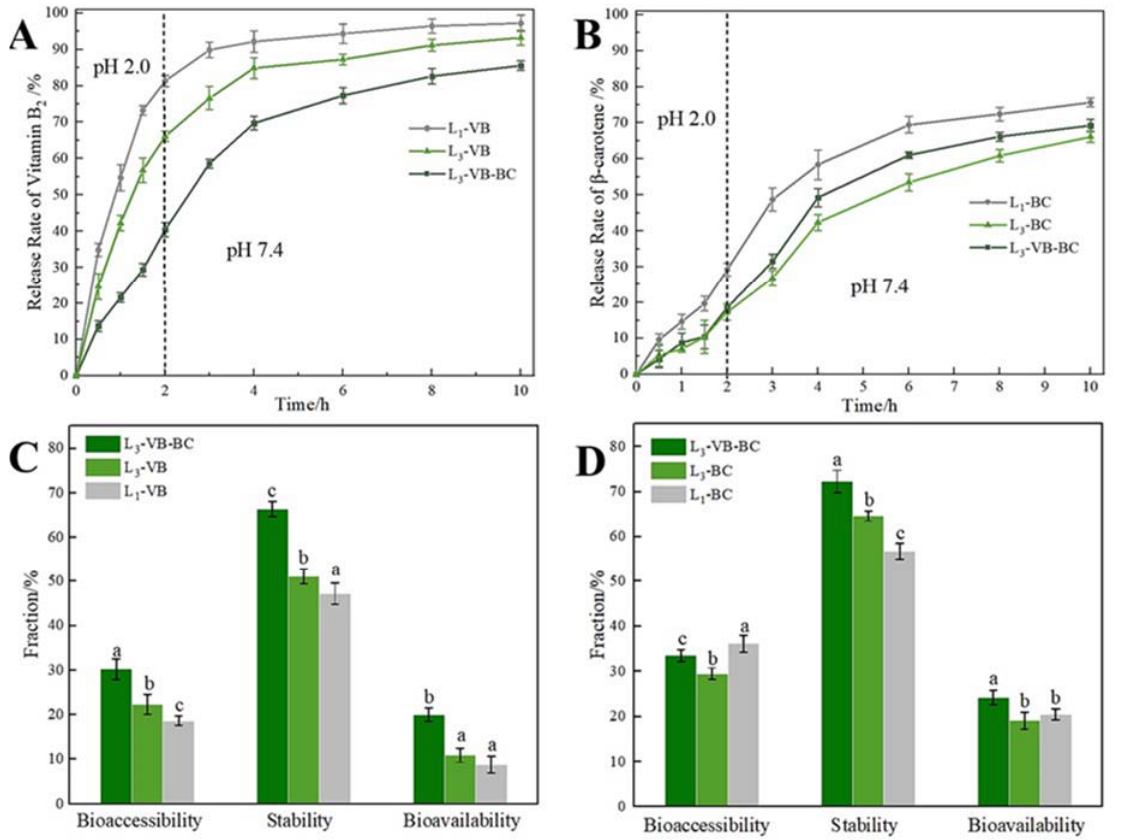
Figure 7. In vitro release studies of VB and BC from the gel microspheres. ( A ) The release profiles of VB from the gel microspheres; ( B ) The release profiles of BC from the gel microspheres; ( C ) Bioavailability, stability, and bioaccessibility of VB; ( D ) Bioavailability, stability, and bioaccessibility of BC. Different lowercase letters indicate significant differences ( p < 0.05) of the same label.